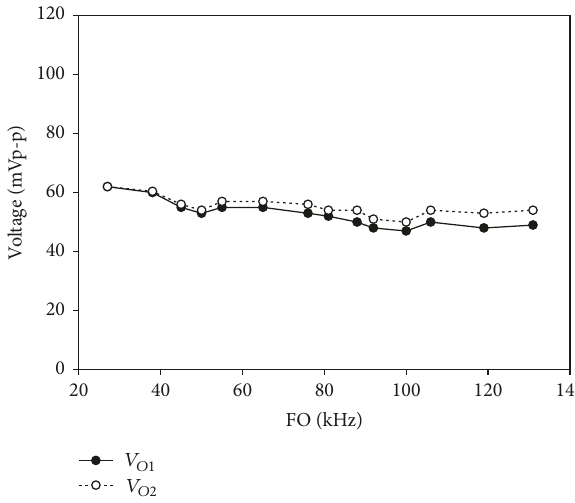
Figure 10: Dependence of amplitudes of 𝑉 𝑂1 and 𝑉 𝑂2 on FO.